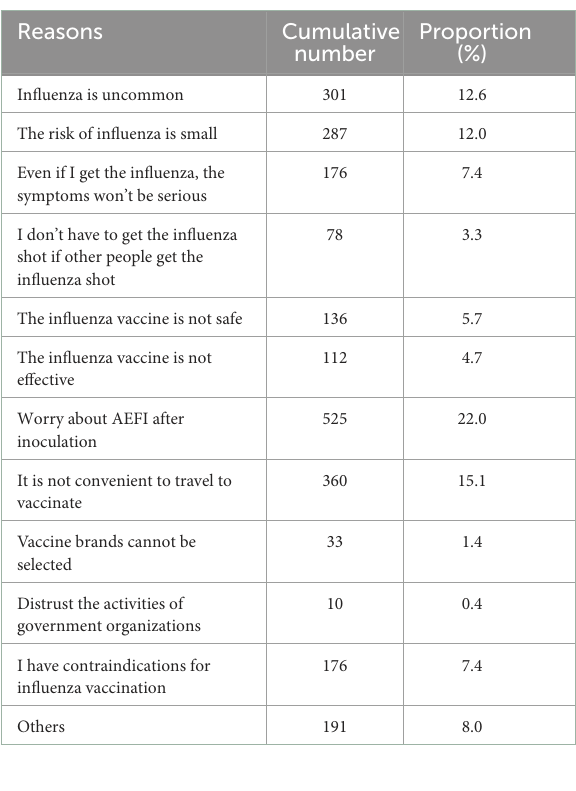
TABLE 6 Statistical table of ways for the elderly aged 70 years and above to obtain health information in